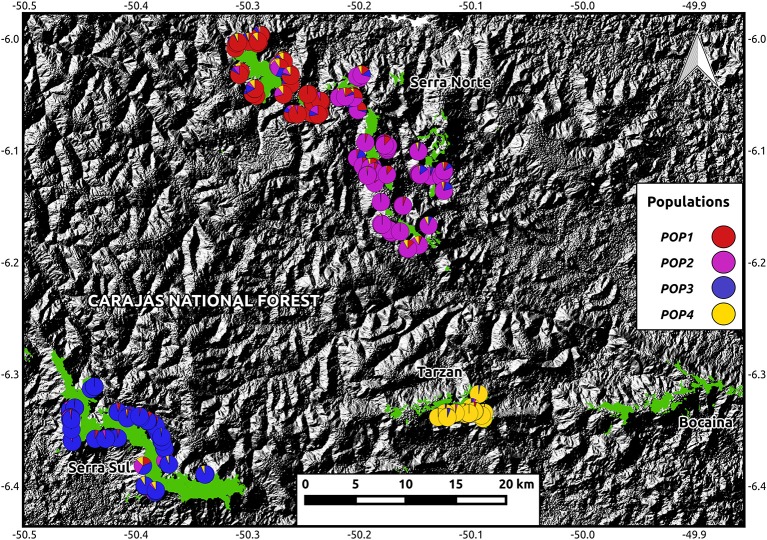
Map showing I. maurandioides assignments to four genetic clusters against an elevation map (from USGS Earth Explorer). Pie charts represent ancestry coefficients determined using the LEA package. Montane savanna highlands (from Souza-Filho et al., 2016) are shown in green. Coordinates are shown in decimal degrees.